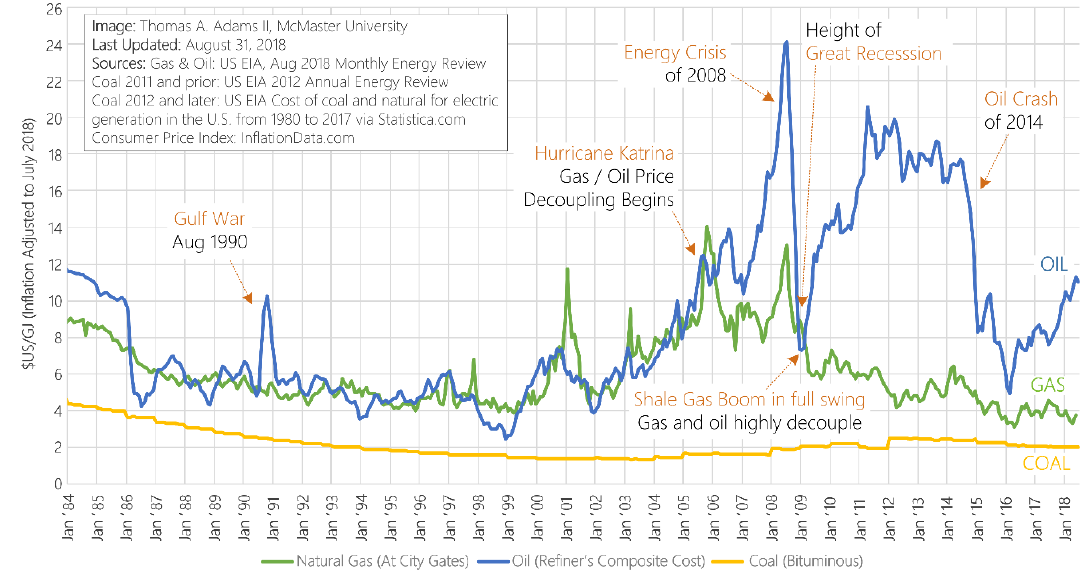
Figure 2. The variation of the normalized prices of natural gas, oil, and coal fuels with a variety of factors such as supply and demand quantities, geopolitics and international trade policies, interaction with other economic sectors, technological changes, and even natural disasters. Coal, gas, and oil prices were collected from various publications from the US Energy Information Administration (see inset) depending on fuel type and year (See inset). Note that a small change in the standard indexing procedure for coal explains a slight jump in coal price at the beginning of 2012. Gas prices are for natural gas located at the city gates (i.e., prior to “last mile” transportation). Oil prices are the refiner’s composite cost of oil, which includes transportation and storage of oil, factoring in both domestic and imported crudes. Coal prices are free-on-board prices and do not include shipping or insurance. Prices are normalized by the consumer price index and converted to an energy basis using the following assumed energy densities: 32 GJ per tonne of coal (using medium-volatility bituminous), 6.118 GJ per barrel of oil, and 1037 BTU per standard ft 3 of natural gas.